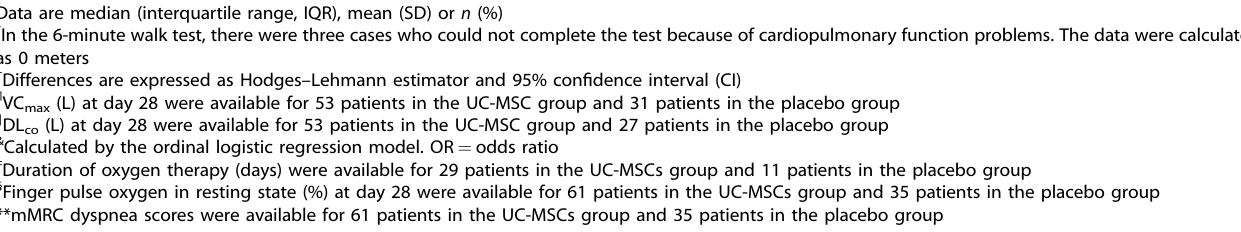
Table 2. Primary and secondary outcomes in the mITT population Change in the total lesion proportion (%) of the whole lung volume from baseline to day